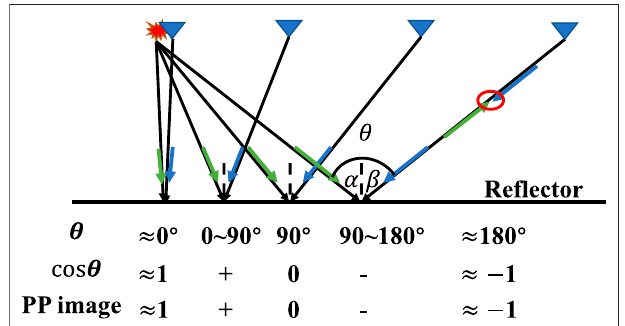
FIGURE 1 | Sign distributions of PP images via the opening angles. The green arrows and blue arrows represent the P-wave incident vectors of the source wave fi eld and the re fl ected vectors of the receiver wave fi eld, respectively. Regardless of the incident and re fl ected vector ’ s modulus, the amplitude of PP images by the dot product scalar imaging condition implicitly depends on the scaling factor cos θ , where the opening angle θ is equal to the sum of the P-wave incident angle α and the re fl ected angle β . As for the unconverted re fl ection wave, the re fl ected angle β is equal to the incident angle α . The sign reversal of the factorcos θ (cid:1) cos 2 α is observed when the incident angle α approaches the critical angle 45 + , which indicates that polarity reversal occurs in the PP image. As marked by the red circle, the factor cos θ reaches-1whiletheincidentangleisnear90 + ,whichexistsinthe propagation path of the backscattering wave. The backscattering artifacts with 180 + or near 180 + scattering angles (i.e., opening angles) also contaminate the PP